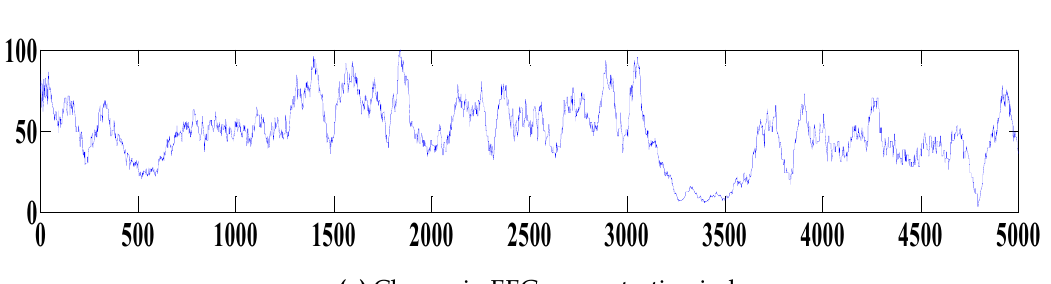
Table 3. Comparison of rate of change between DLE Index and CI